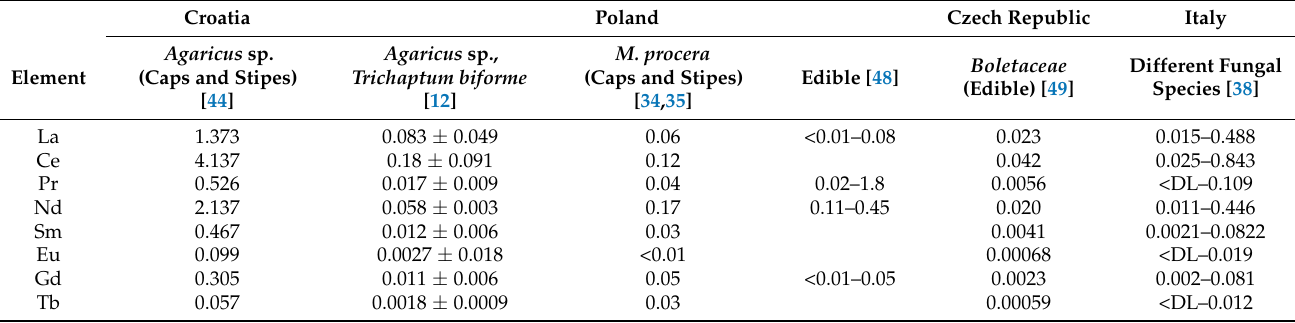
Table 5. The comparison of the determined REY concentration with the literature values for mushrooms from different regions (all expressed in mg/kg). If not otherwise specified, the results refer to the fruiting body. Croatia